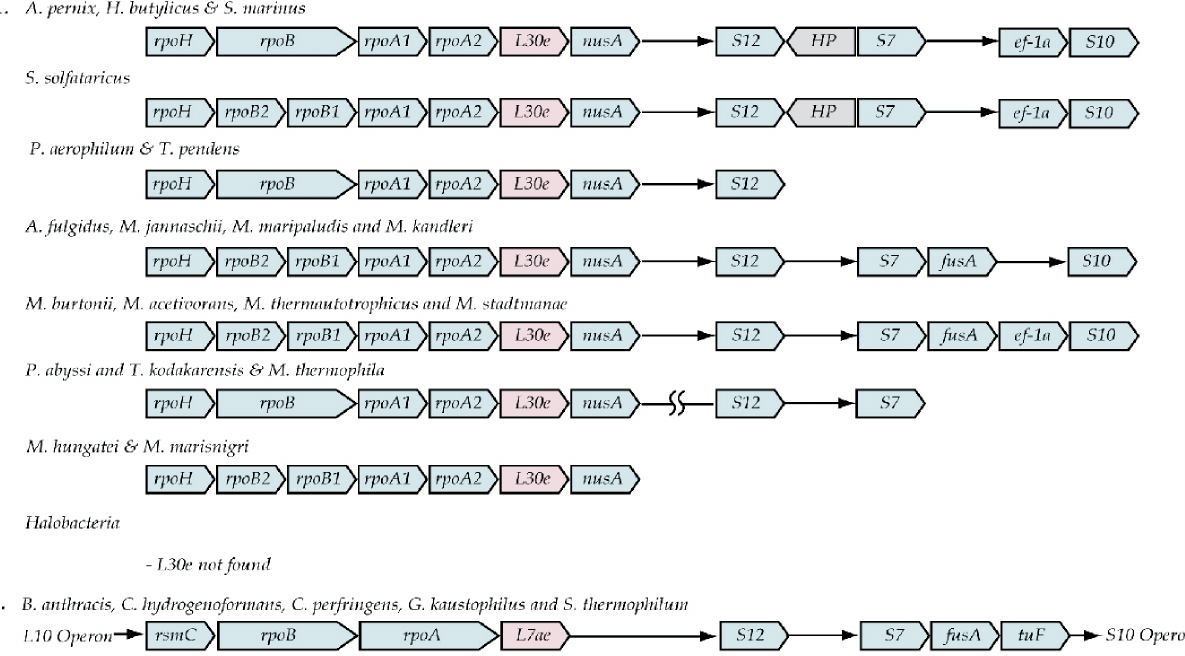
Figure 3. Alternative versions of the gene cluster containing the gene encoding L30e in the Archaea. Labels are as in Figures 1 and 2. Group A shows the archaeal arrangements and Group B is the arrangement typically found in the Firmicutes. The gene which is homologous to the gene for L30e in the Firmicutes is typically incorrectly annotated as a second copy of the gene encoding L7ae as discussed in the text.